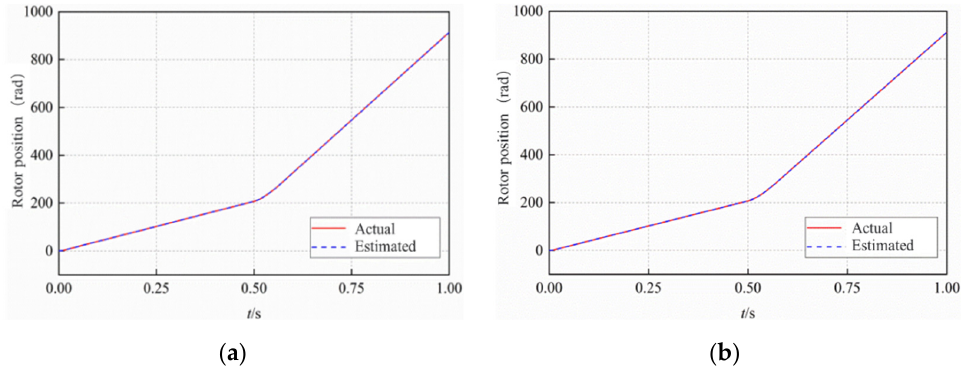
Figure 12. Simulation waveform of rotor position under speed mutation. ( a ) Traditional MRAS algorithm. ( b ) STSM − MRAS algorithm.